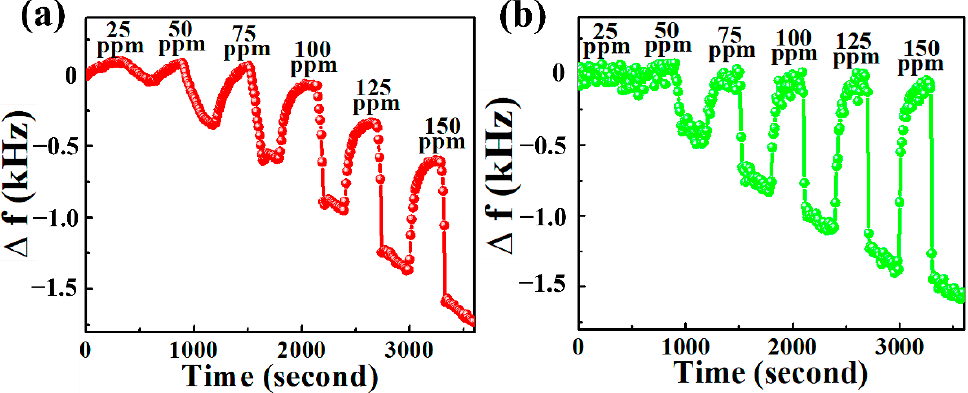
Figure 8. Frequency shifts of ( a ) NGO@MnO 2 and ( b ) NGO@MnO 2 /PPy in the SAW sensor ( T = 20 °C, R.H. = 25–30%) .